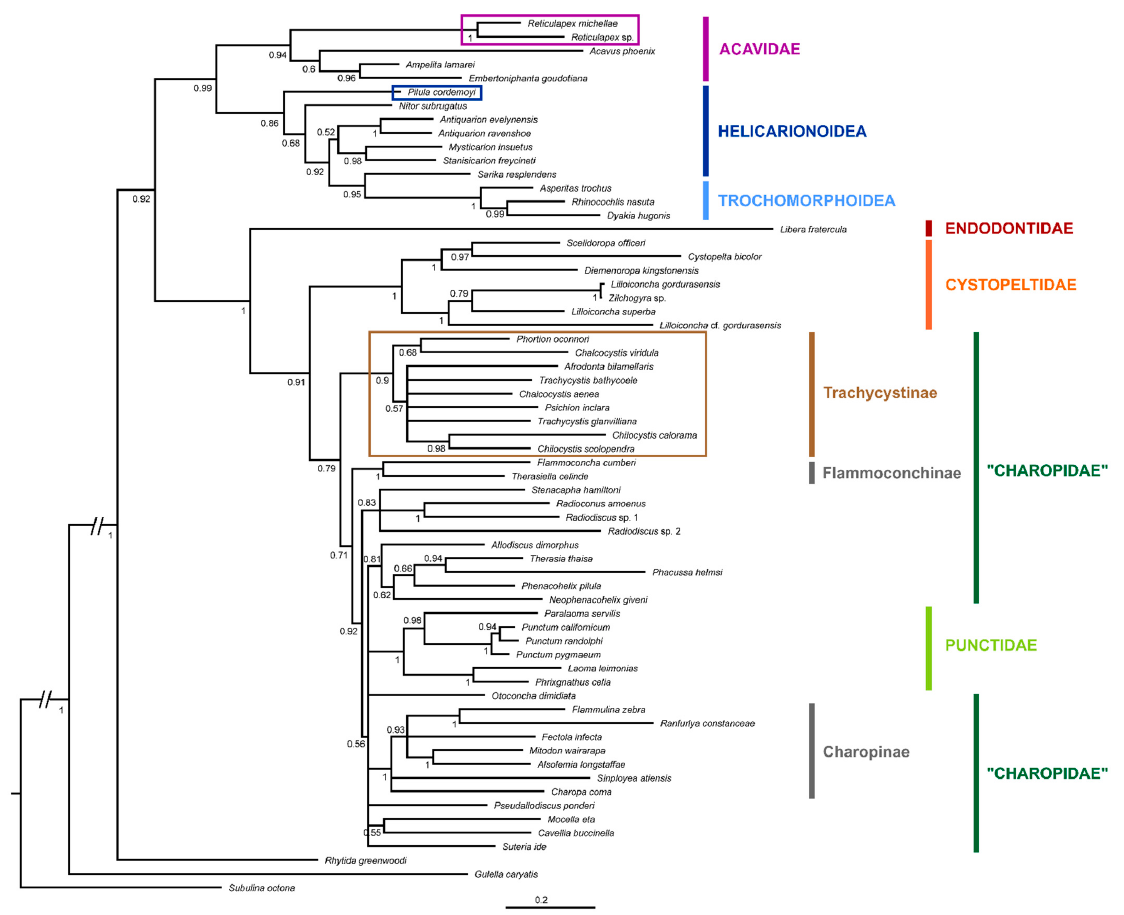
Figure 1. Bayesian inference phylogenetic tree based on CO1, 16S, and ITS2+28S with a focus on African taxa. Posterior probabilities are shown on nodes. Scale bar = substitutions per site.